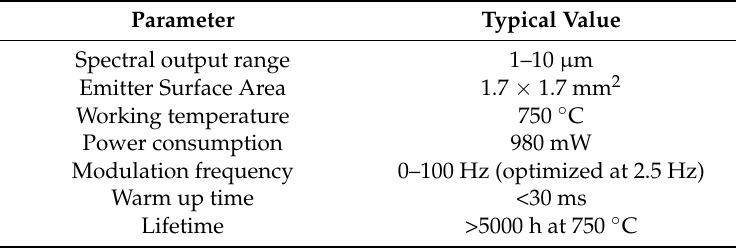
Table 1. Features of infrared (IR) source